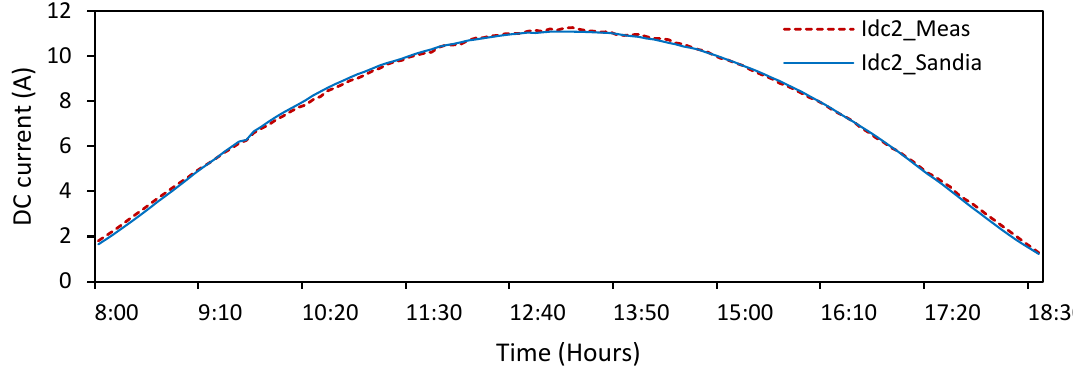
Figure 9. Measured Vs. estimated MPP current of the PV sub-array N°2. Table 8. Regression metrics of DC current models simulated for three sub-arrays. Metrics/Param.